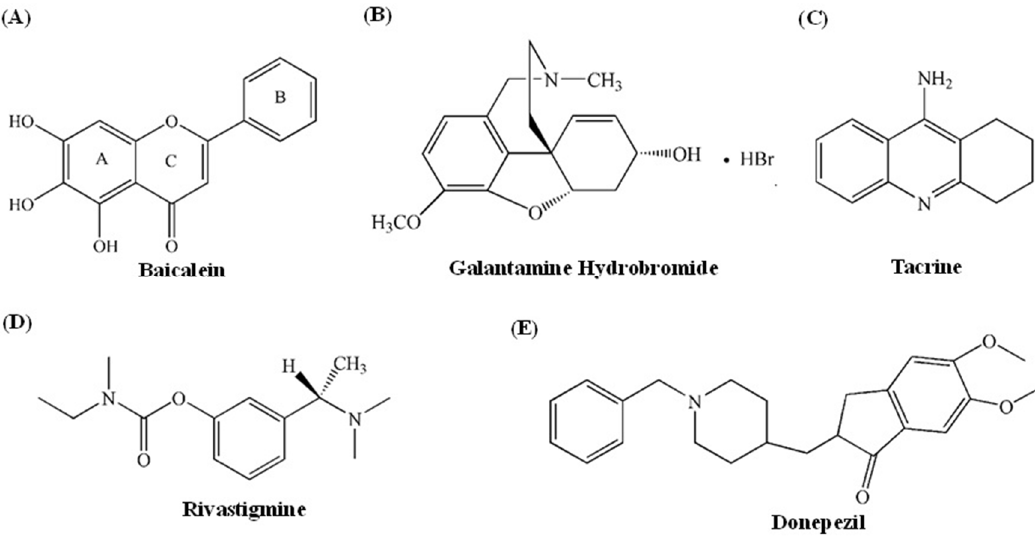
Figure 1. Structure of baicalein (A) and FDA-approved AChE inhibitors